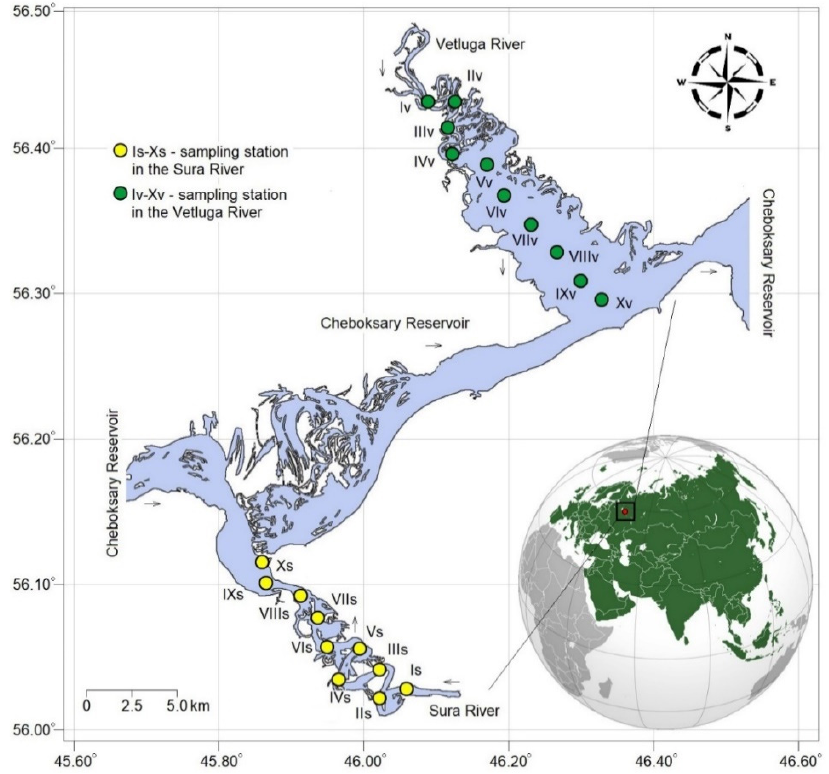
Figure 1. Map showing the location of the sampling stations in the Vetluga and the Sura rivers (tributaries of the Cheboksary Reservoir, Middle Volga basin, European Russia).